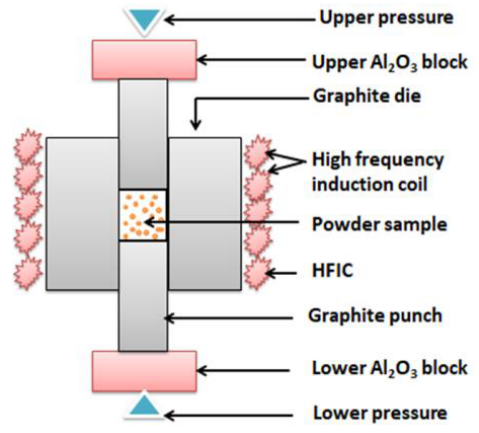
Figure 7. High frequency induction heat sintering device, adapted from [161].